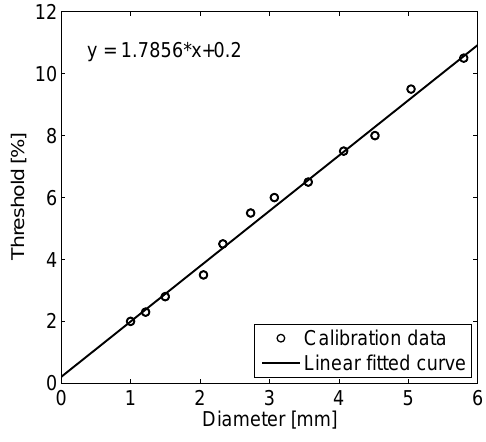
Figure 9. Relative error of diameter versus diameter (threshold = 3 %).